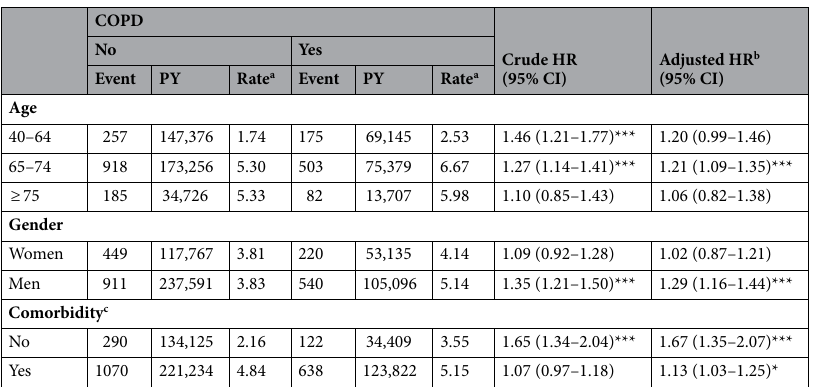
Table 3. Incidences and hazard ratios of age-related macular degeneration for patients with COPD compared to individuals without COPD. CI, confidence interval; COPD, chronic obstructive pulmonary disease; HR, hazard ratio; PY, person-years. * p < 0.05, *** p < 0.001. a Incidence rate per 1000 person-years. b Multivariable analysis including age and comorbidities of hypertension, diabetes, hyperlipidemia, CLD, and rheumatic disease. c Individuals with any comorbidity of hypertension, diabetes, hyperlipidemia, CLD, CKD, and rheumatic disease were classified into the comorbidity